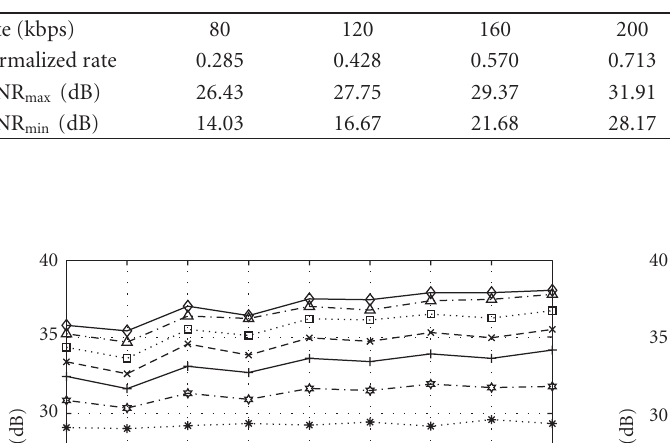
Table 3: Performance bounds of PRED.